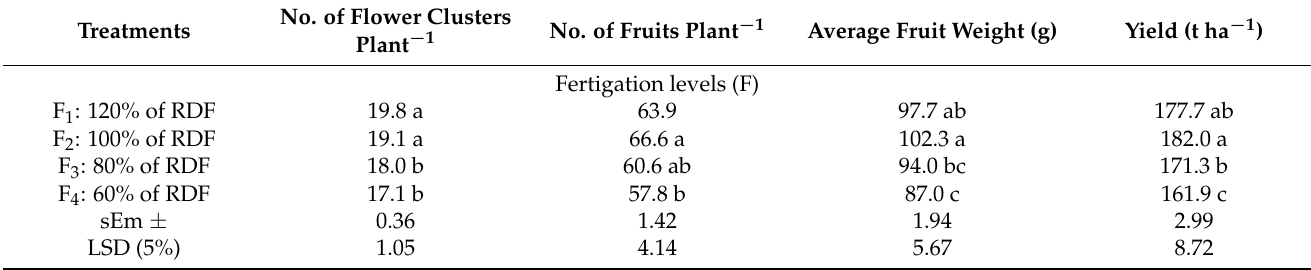
Table 5. Impact of fertigation doses and their scheduling on growth and yield attributing parameters in tomato (2-years pooled